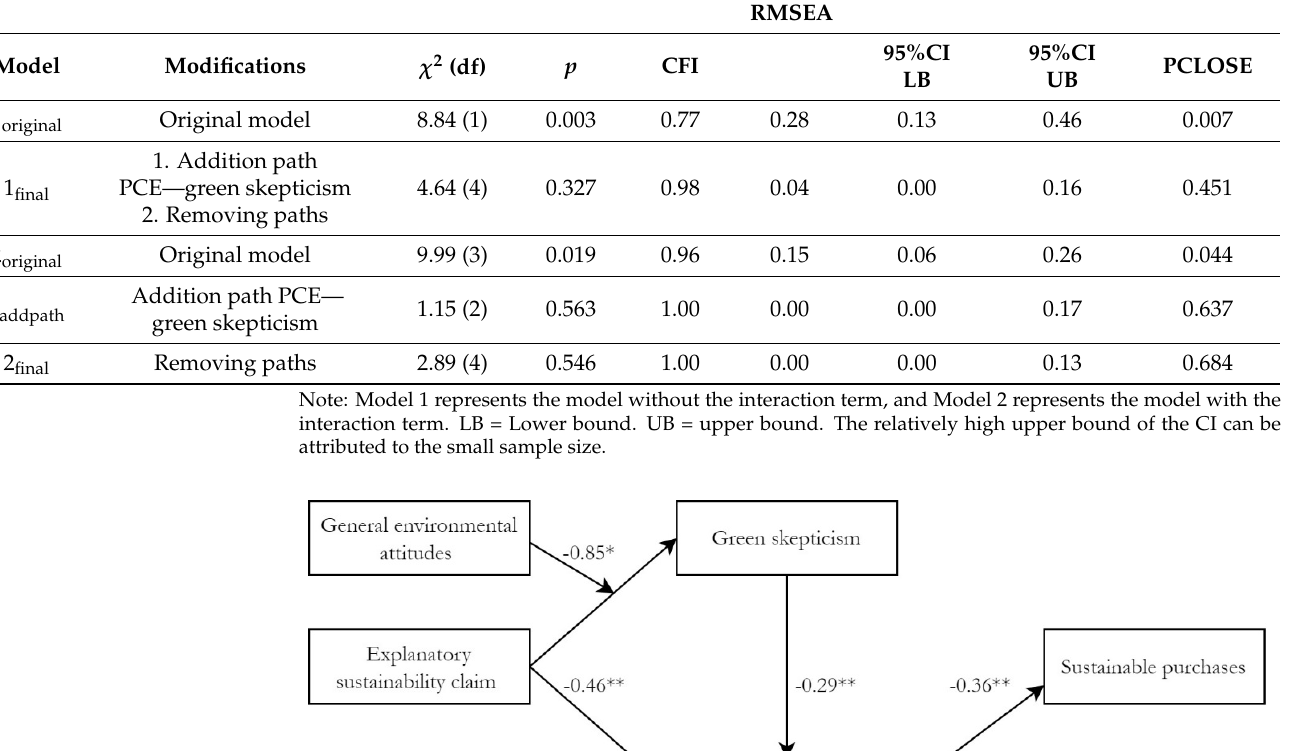
Table 4. Re-specification steps and fit indices.